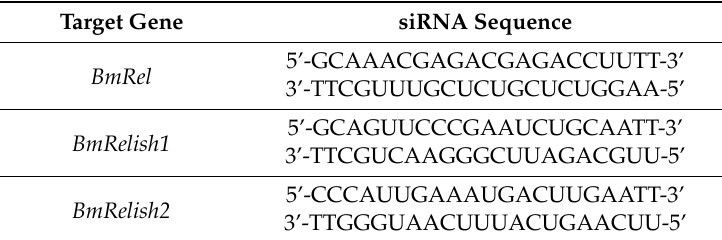
Table 1. Small interfering RNA (siRNA) for silencing target